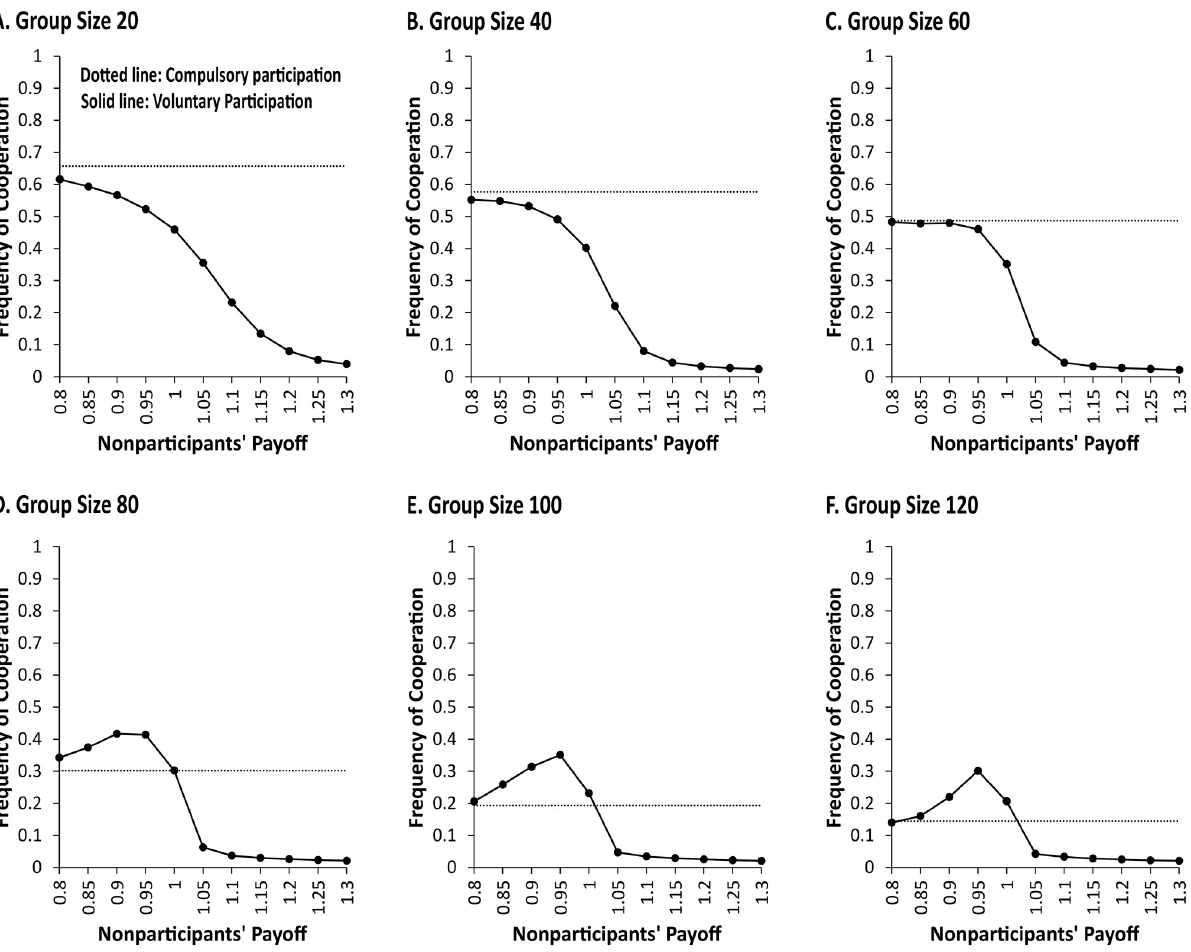
Fig 1. Asymmetric effects of voluntary participation on the long run average frequency of cooperation. Dotted lines show the simulation results of 100 runs of the compulsory participation scenario, and solid lines the results of the voluntary participation scenarios. Asymmetric effects are found in two dimensions, i.e., nonparticipants’ payoff and group size. First, only within a certain range of nonparticipants’ payoff (between 0.8 and 1.0), voluntary participation leads relatively large groups ( n = 80, 100, and 120) to achieve higher frequencies of cooperation than compulsory participation. Note that the highest frequency of cooperation is observed when nonparticipants’ payoff ( O ) is 0.95 which is the same as a contributor’s payoff in a group where the faction of cooperators is 30% ( x = 0.3); and the frequency of cooperation drops sharply when nonparticipants’ payoff increases to 1.05 which is the same as a contributor’s payoff in a group where the fraction of cooperators is 50% ( x = 0.5). Second, such positive effects of voluntary participation are not observed in relatively small groups ( n = 20, 40, and 60) regardless of changes in nonparticipants’ payoff. The data used in this figure are provided in S1